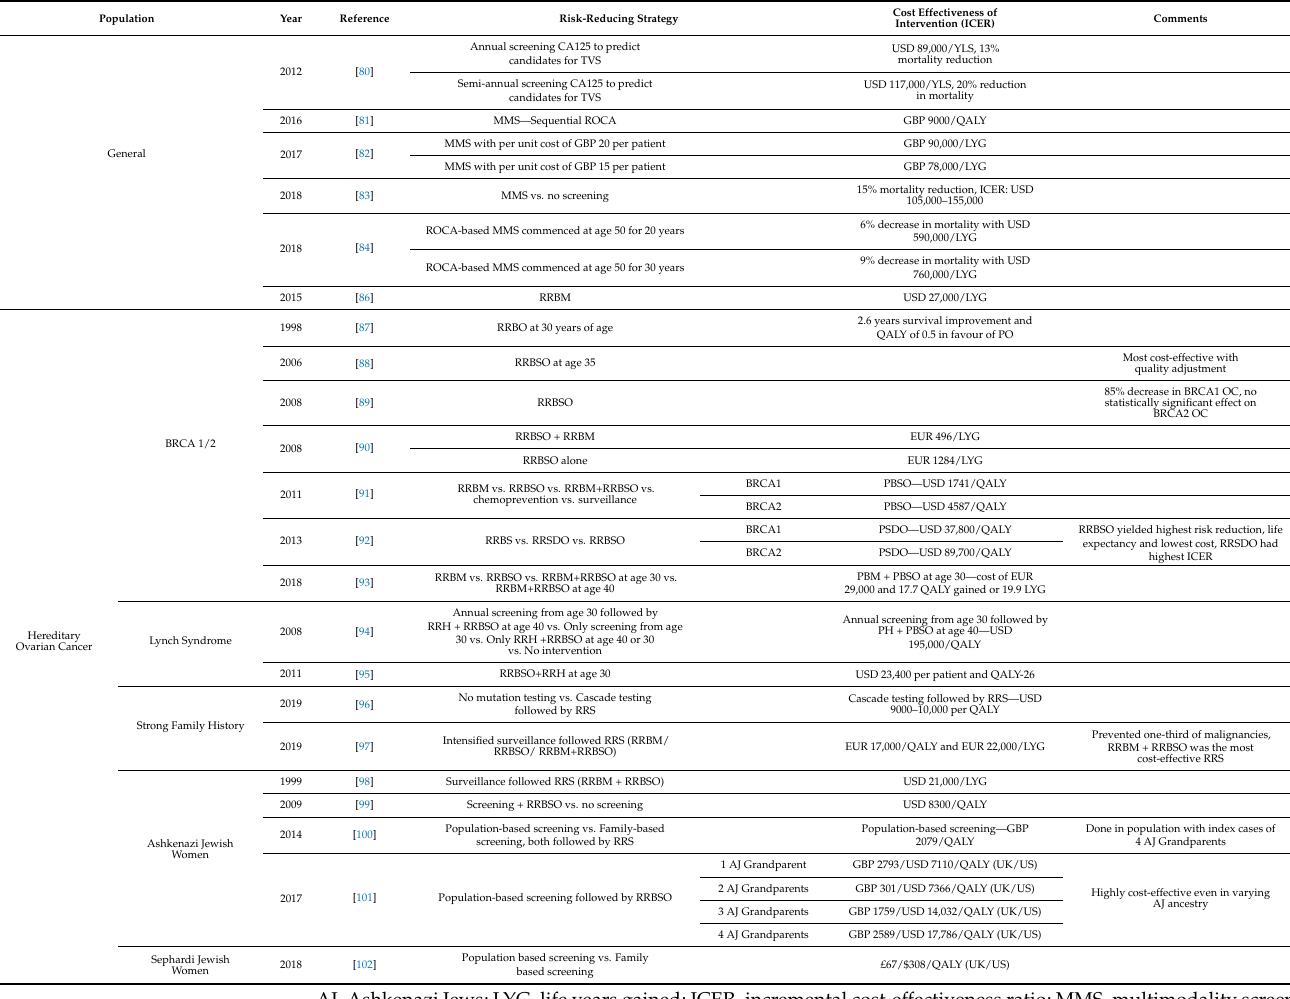
Table 2. Cost effectiveness of prevention